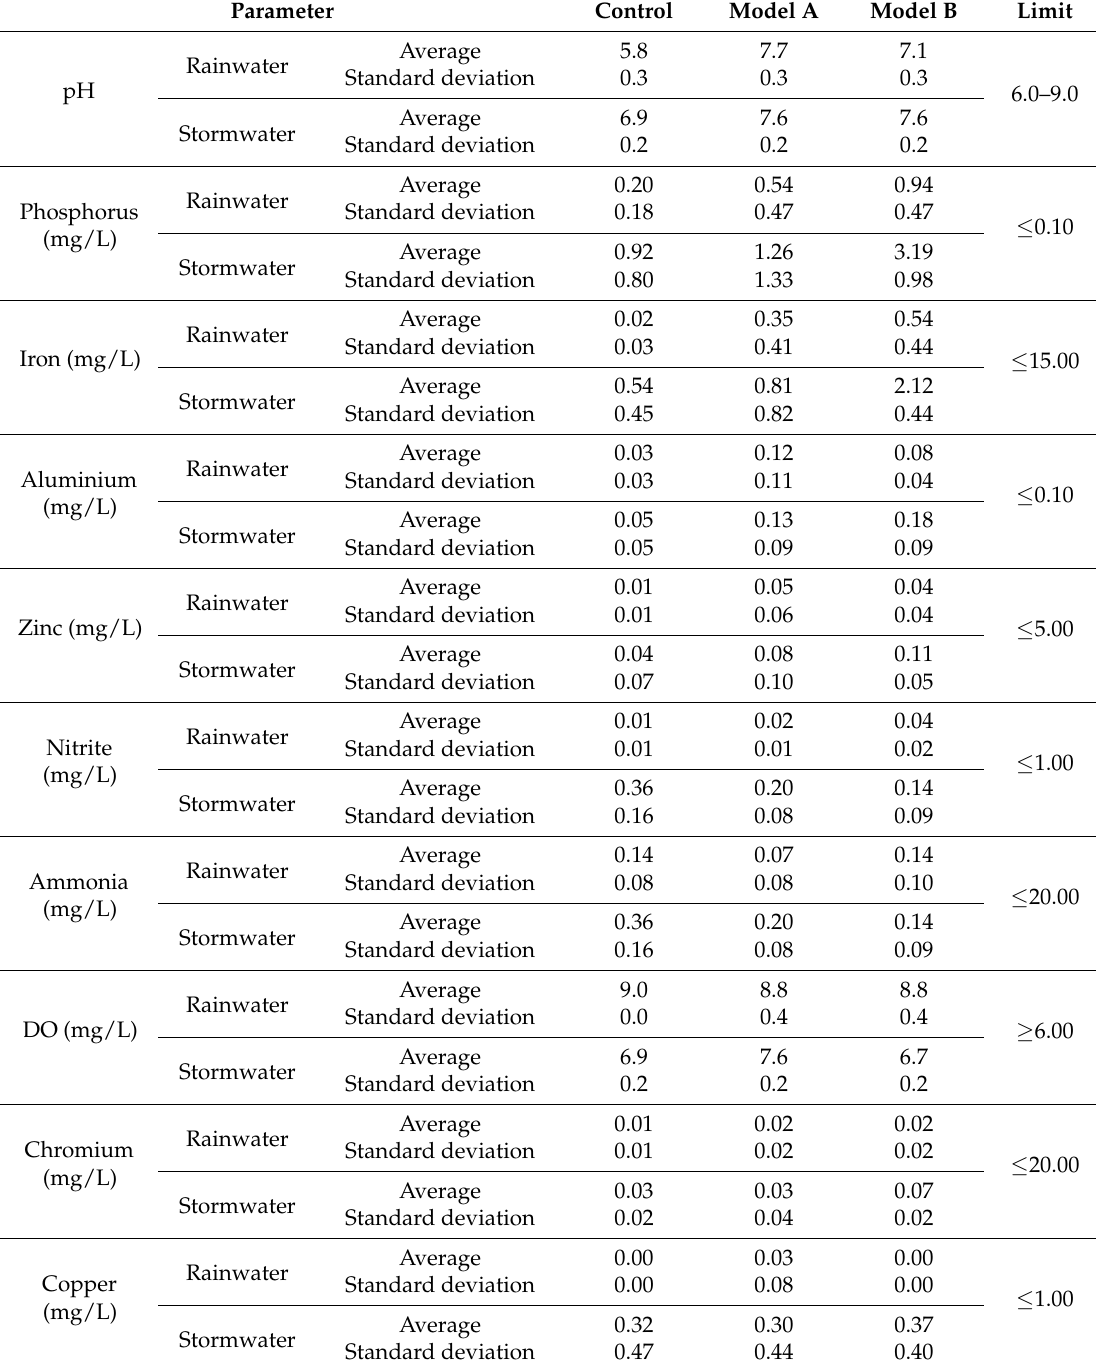
Table 4. Average concentrations of all parameters and limits imposed by